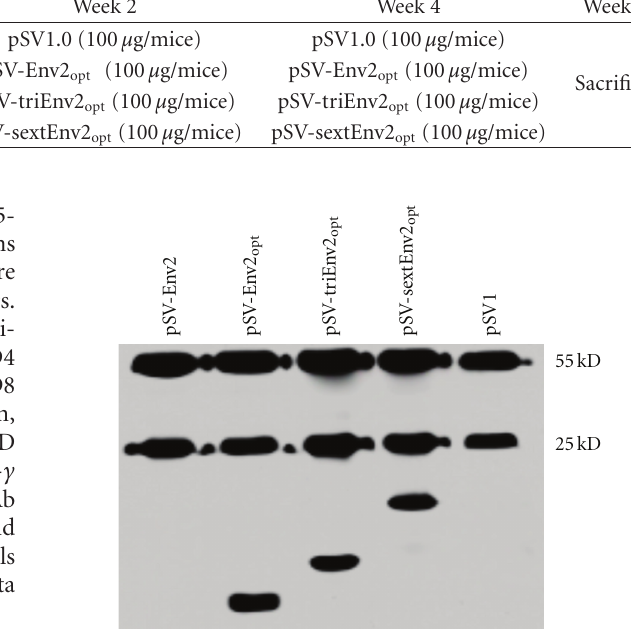
Figure 2: In vitro expression of epitope-based DNA vaccines. The expression products of epitope-based DNA vaccines were first precipitated with mouse anti-His antibody (IgG) and then detected by western-blotting. The coprecipitated heavy (55KD) and light chains (25KD) of mouse IgG served as internal controls. The relative expression levels were similar among pSV-Env2 opt , pSV- triEnv2 opt , and pSV-sextEnv2 opt , while, the expression of pSV-Env2 could not be